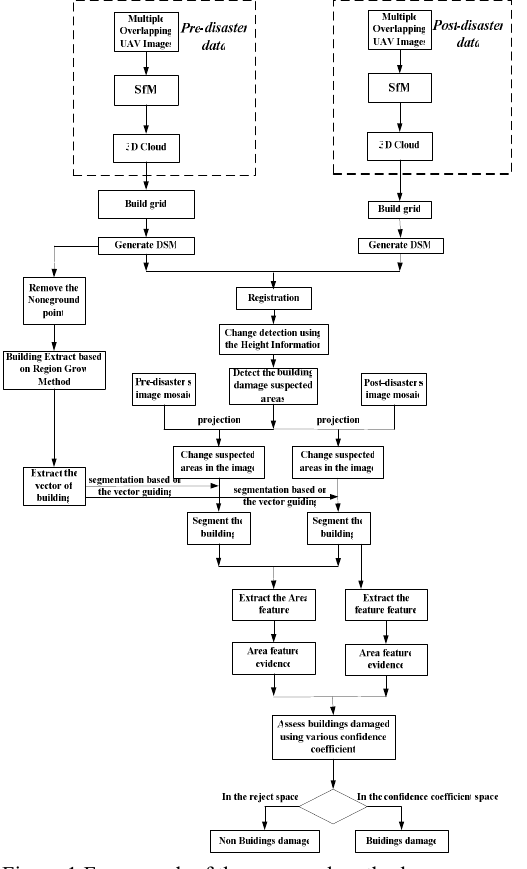
Figure.1 Framework of the proposed method 2.1 DSM generated with Multiple Overlapping UAV Images Three-dimensional reconstruction from images is one of the fundamental problems in the fields of computer vision and photogrammetry, at present many multiview methods are capable of computing highly accurate 3-D point as well as camera calibration information simultaneously using the constraints imposed by feature matches across multiple images(so called “structure from motion”). 3D cloud are generated by using SfM algorithm based on the multiple overlapping UAV images, then DSMs are generated using 3D cloud. Each point’s gray value of 3D cloud in the 256 colors gray images is computed